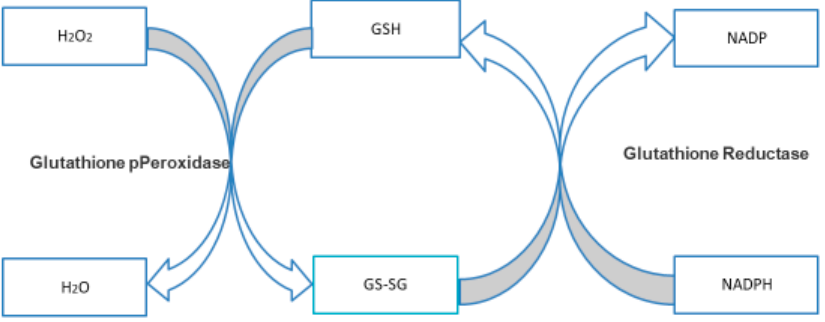
Figure 2. Glutathione Reductase Cycle.